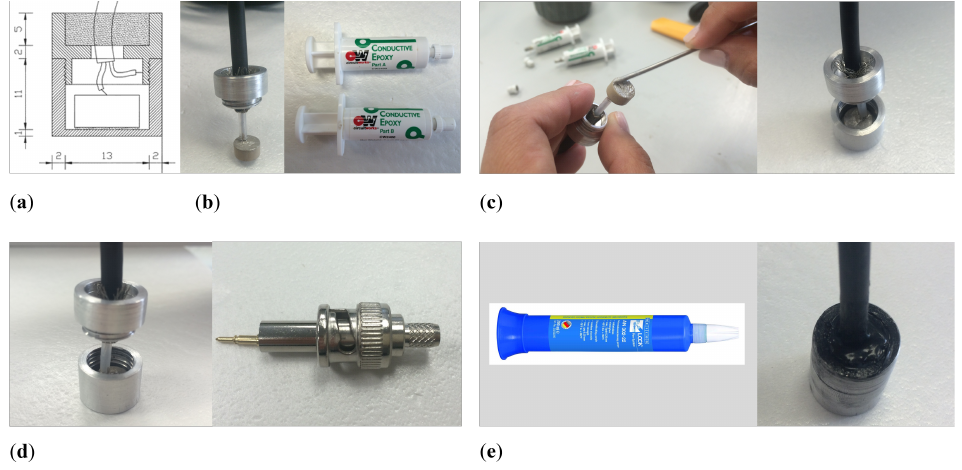
Figure 7. Sensor manufacturing process. ( a ) Design of the housing, measures in millimeters; ( b ) Coax- ial cable attached to the positive pole of the ceramics; ( c ) Ceramic bonding to the housing; ( d ) Shielding of the cable with housing; ( e ) Sealed sensor.